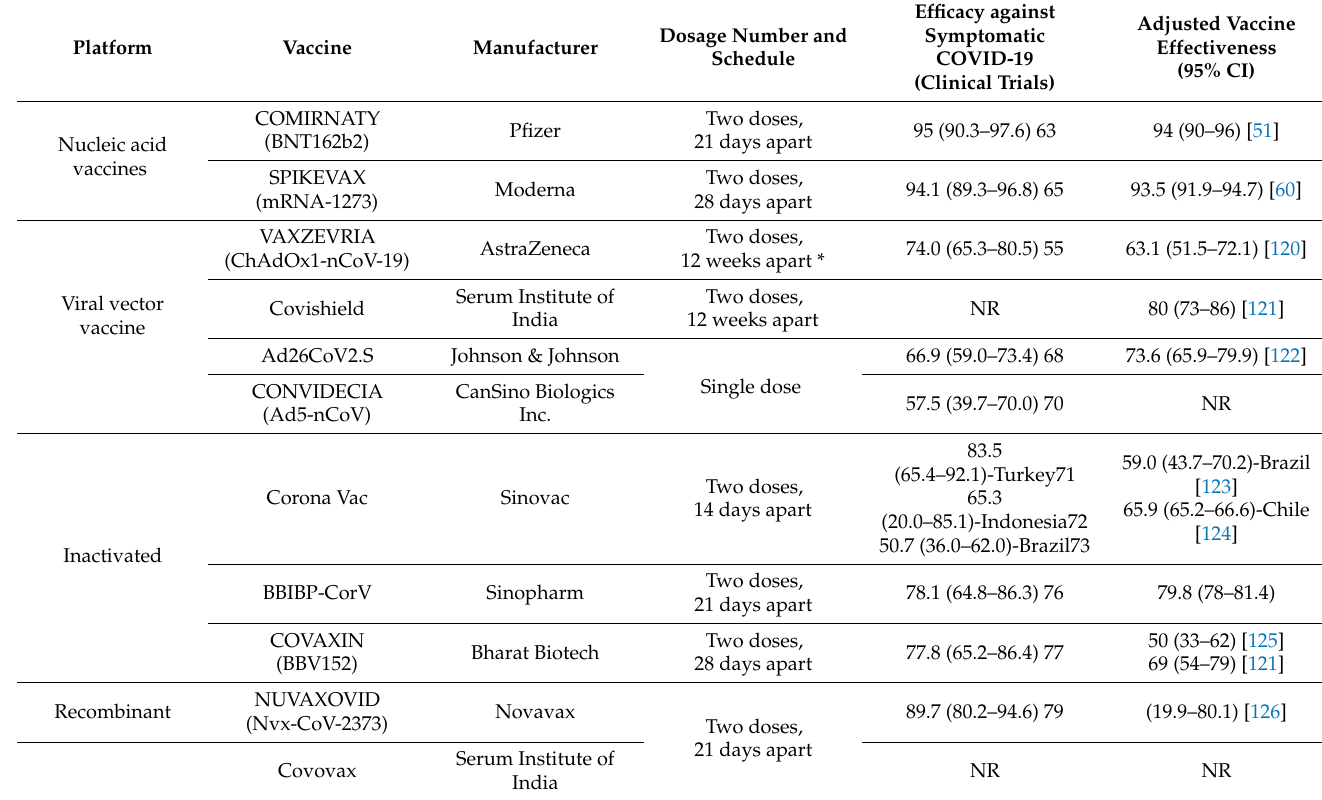
Table 1. Comparison Of WHO EUA Qualified COVID-19